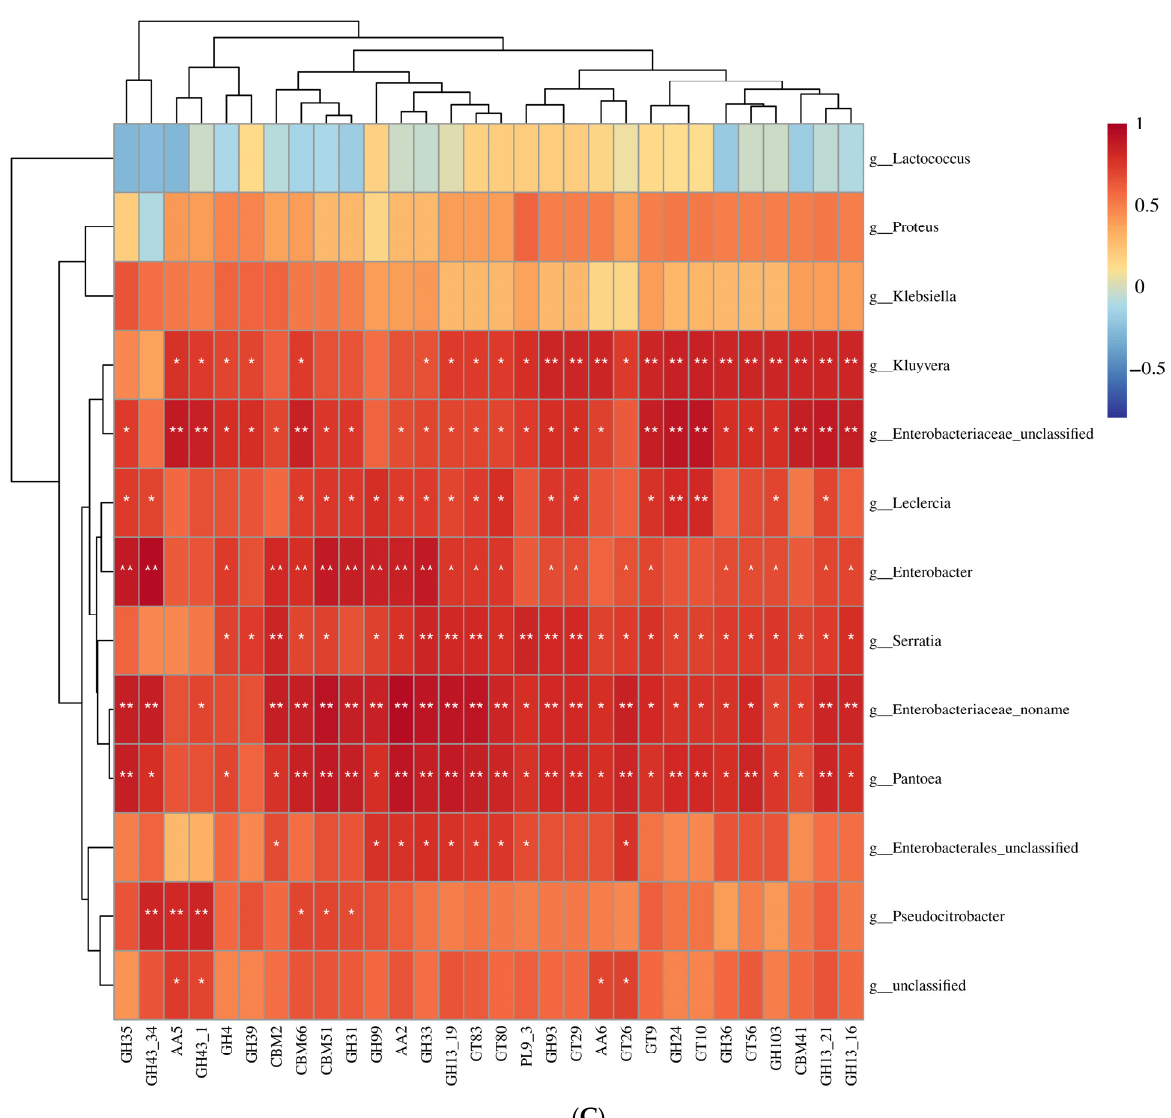
Figure 5. Comparison of the genes assigned to the CAZymes database. ( A ) Classification of CAZyme families in the samples. ( B ) The different abundant genes assigned to CAZy level 2. ( C ) Correlation analysis between microbiota and CAZymes (*, p < 0.05; **, p < 0.01).